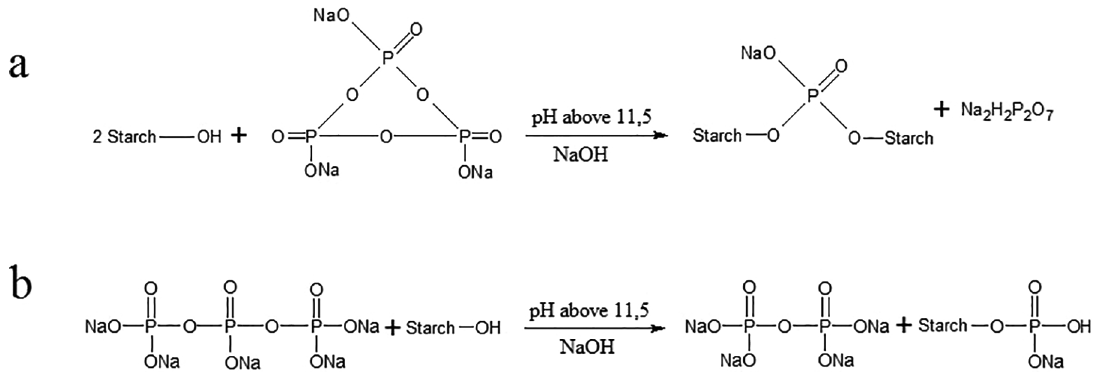
Figure 1. Propositions of Starch Phosphorylation Reactions with (a) STMP and (b) STPP in alkaline